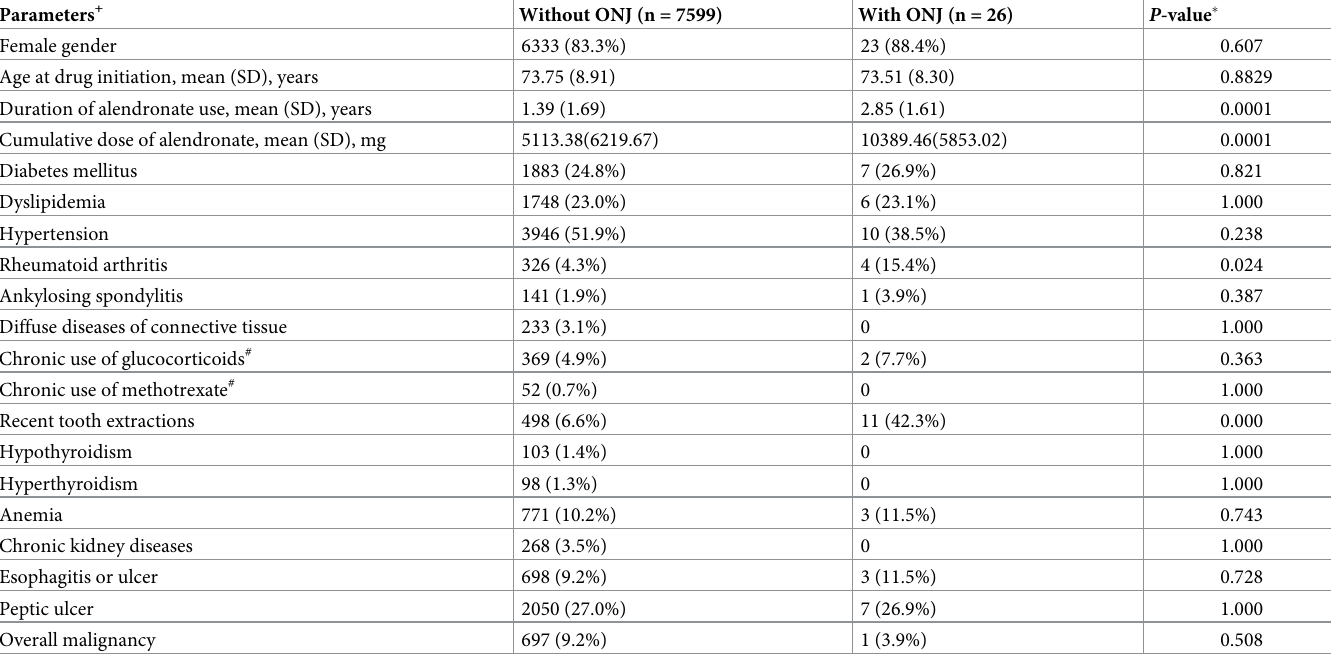
Table 1. Clinical characteristics of patients taking alendronate with and without osteonecrosis of the jaw (ONJ). Parameters +